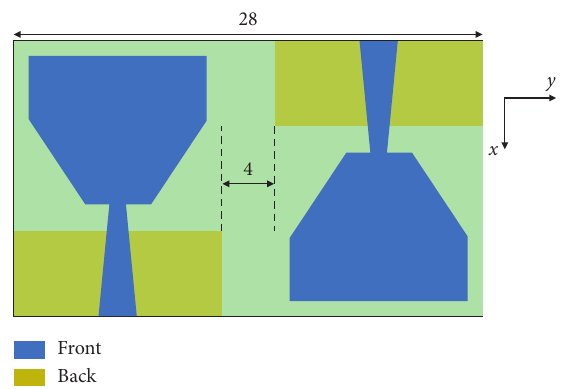
Figure 4: Schematic diagram of UWB MIMO antenna structure without decoupling structure (mm).